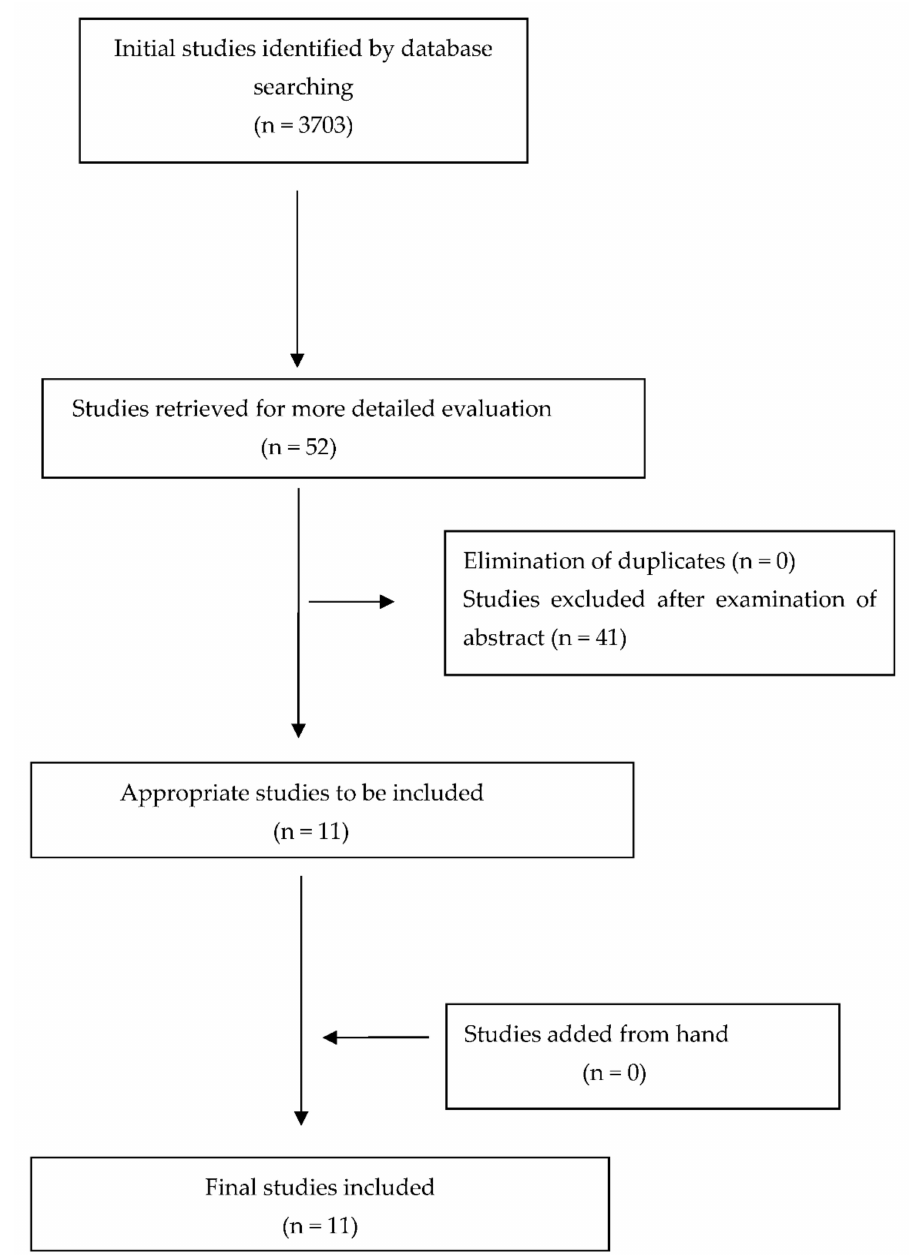
Figure 1. Flow diagram—selection of